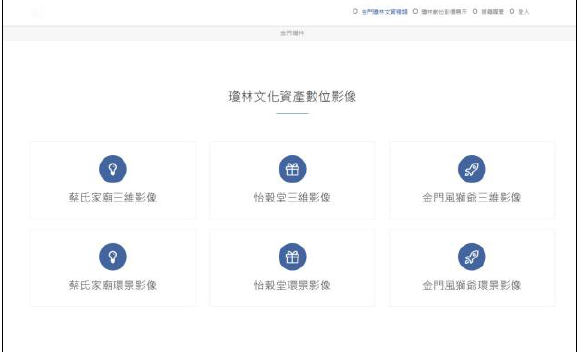
Figure 8. Connection function of system